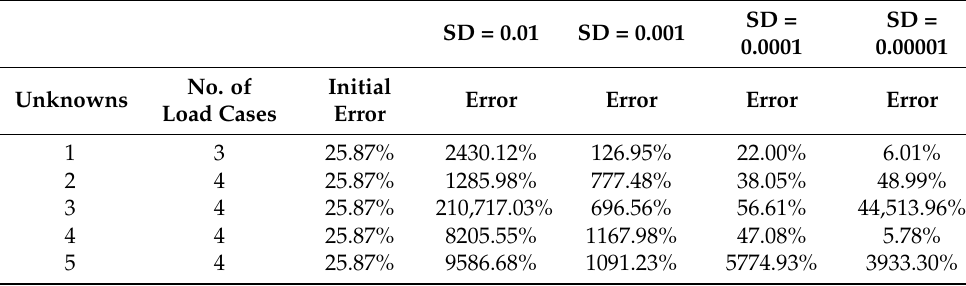
Table 15. Errors obtained for thermal parameters for transient 16 nodes model.